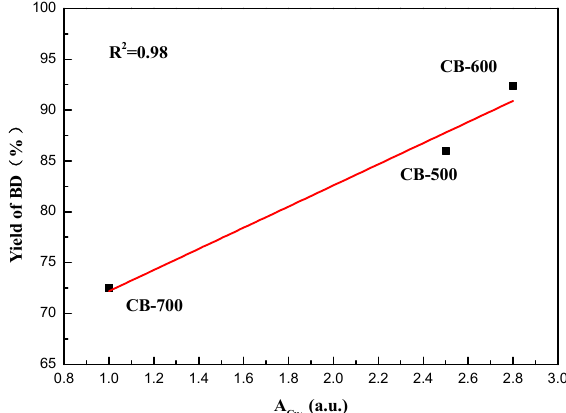
Figure 10. BD yield after 15 h at 90 °C as a function of the integrated area of the CO-IR peak.